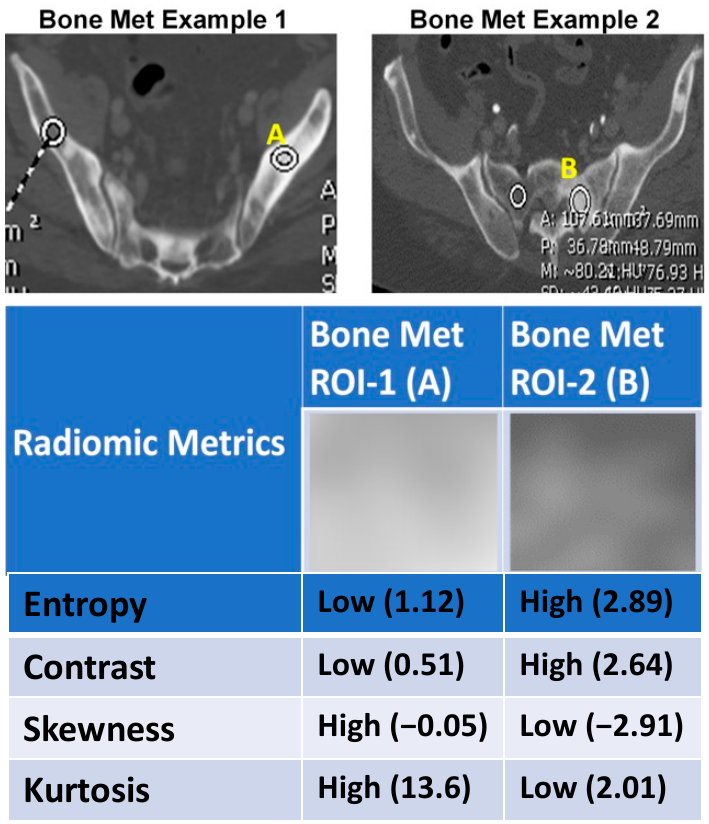
Figure 6. Visual representation of select radiomic metrics. Sample structured report with values of the intensity characterization metrics, namely entropy, contrast, skewness and kurtosis, obtained across two different bone metastatic lesion from two different patients.